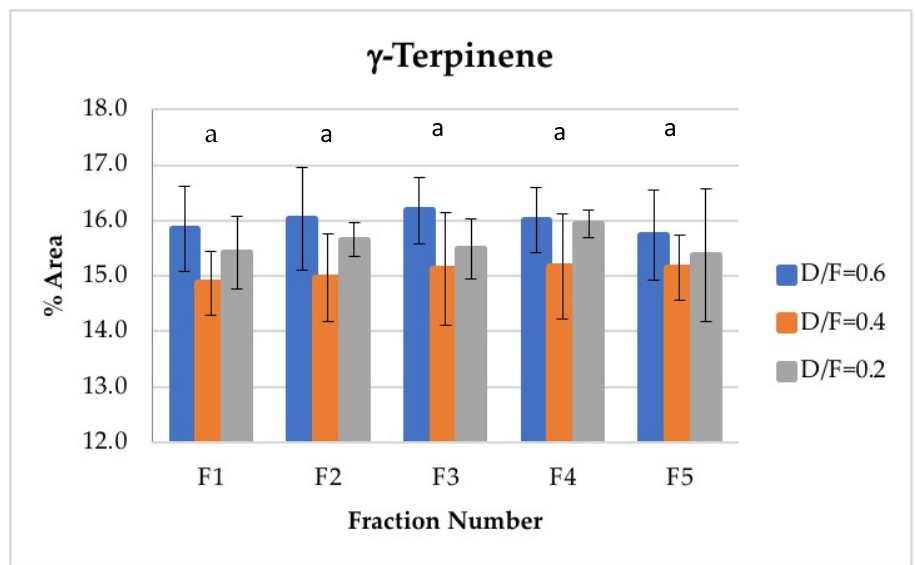
Figure 7. Abundance profile vs. number fraction for d-limonene. The results are the average of three replicates ± standard deviation. Different letters over a column indicate statistical differences (Tukey, p < 0.05).